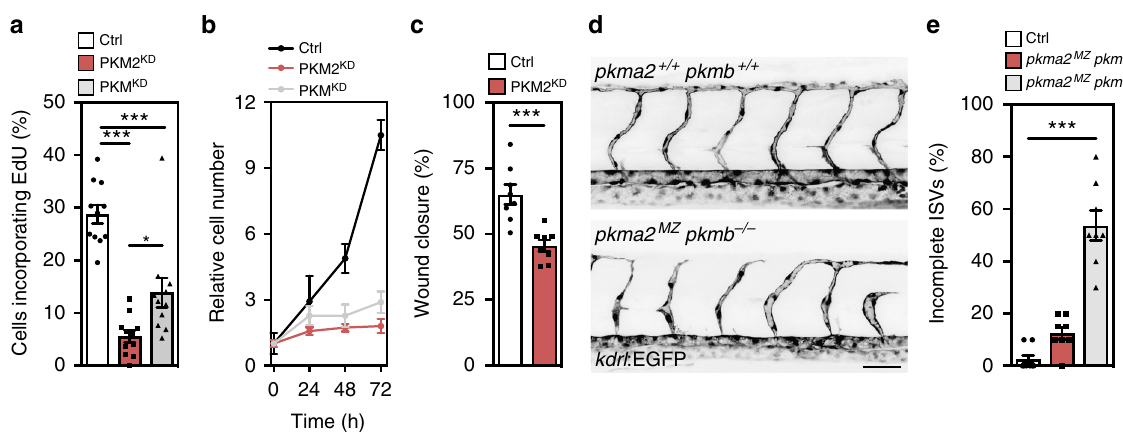
Fig. 2 Loss of PKM2 leads to angiogenic sprouting defects. a EdU-positive cell numbers in control, PKM2 KD and PKM KD ECs ( n = 11). b Relative cell numbers at the indicated time points in control, PKM2 KD and PKM KD ECs ( n = 6). c Scratch wound assay in control and PKM2 KD ECs ( n = 8). d Representative confocal projections of 48 hpf Tg(kdrl:EGFP) pkma2 + / + pkmb + / + and pkma2 MZ pkmb − / − zebra fi sh embryos (scale bar = 50 μ m). e Percentage of intersegmental vessels (ISVs) that have failed to connect with neighbouring ISVs in 48 hpf zebra fi sh embryos ( n = 8). Data in a – c and e represent means ± s.e.m. (*** P < 0.001 by one-way analysis of variance (ANOVA) followed by Tukey ’ s HSD test ( a , e ) or two-tailed Student's t test ( c ))